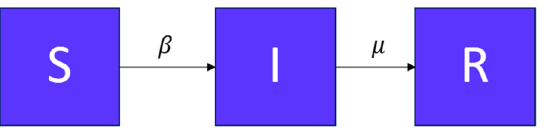
Figure 2. Scheme of the SIR